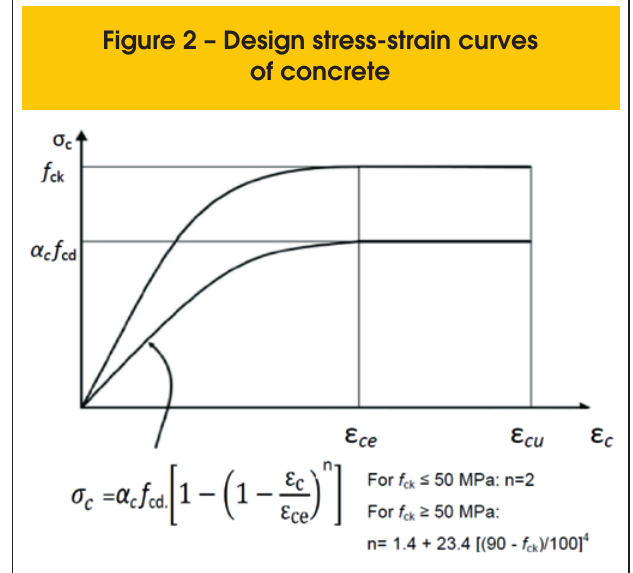
Figure 2 – Design stress-strain curves of